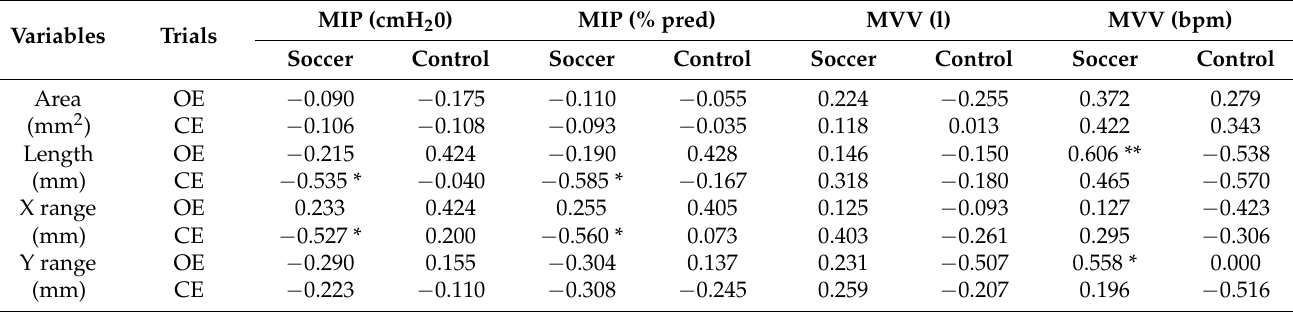
Table 2. Pearson’s correlation between respiratory muscle strength and stabilometric variables in soccer player and control